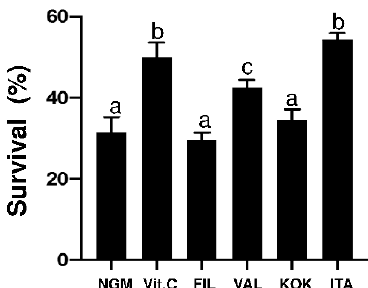
Figure 2. C. elegans survival (%) in the different conditions assayed (100 µg/mL) of the Morus alba leaves extracts( MAE) of different genotypes.